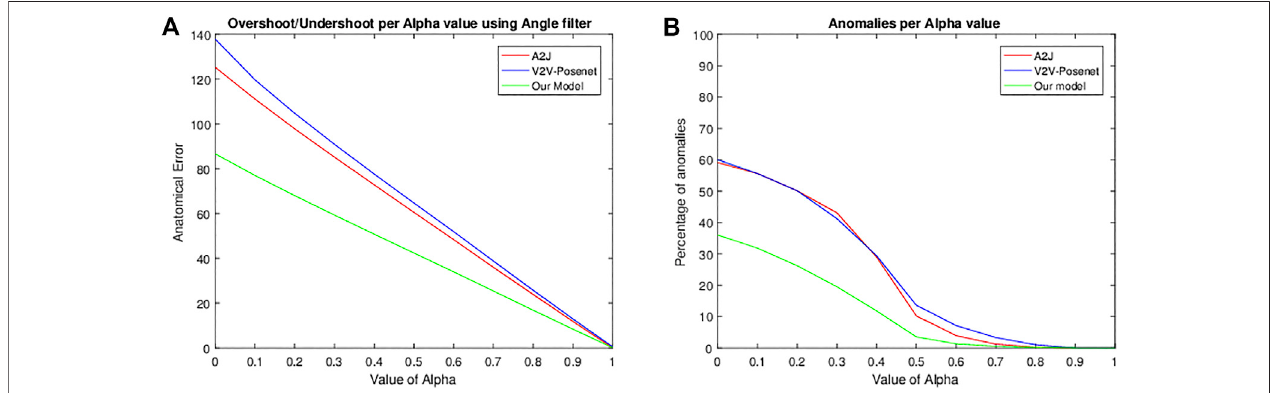
FIGURE 5 | Graphical visualization of the anatomical errors of two state-of-the-art models, namely A2J (Xiong et al., 2019) in (A) and V2V-Posenet (Moon et al., 2018)in (B) compared toourmodel using the angle fi lterattached tothe end ofthe model forevery valueof α .The x-axis corresponds to thevalue of α used forthe fi lter. The y-axis in (A) corresponds to the model ’ s anatomical error, which is the mean joint degree that overshoots or undershoots the anatomical bounds of the corresponding joint of the hand. In (B) , the y-axis corresponds to the percentage of frames in which the anatomical error exceeded 100 degrees.